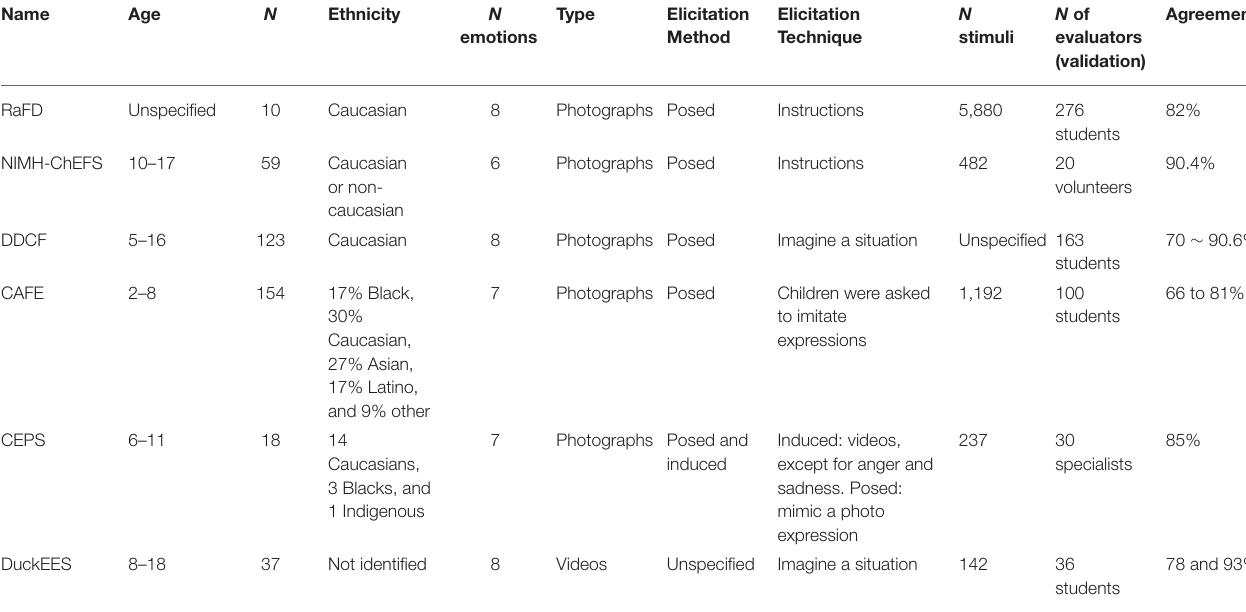
TABLE 1 | Published photo and video databases of children’s facial